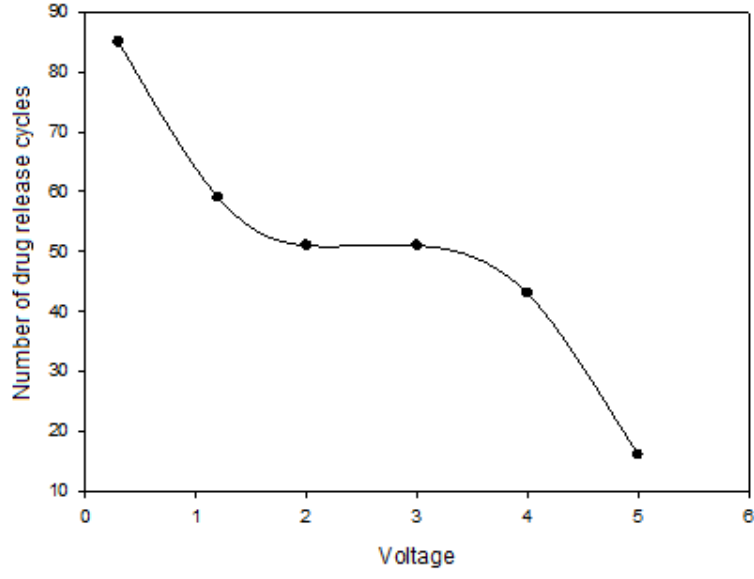
Figure 3. Profile showing the number of release cycles obtainable from the ECH at a specified applied